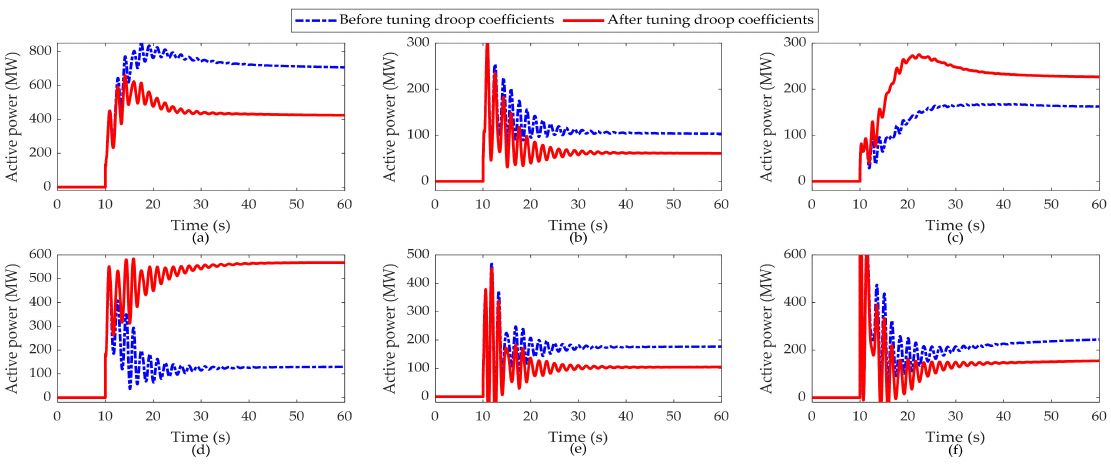
Figure 11. Total output power from SGs for case study 2. ( a ) Region 1, ( b ) Region 2, ( c ) Region 3, ( d ) Region 4, ( e ) Region 5, and ( f ) Region 6.